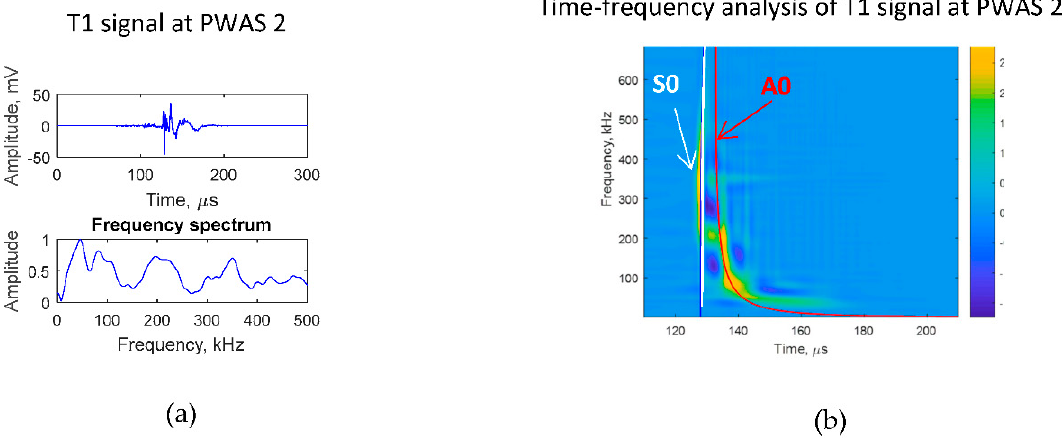
Figure 15. Time-frequency analysis of T1 AE signal at PWAS–2: ( a ) T1 signal at PWAS–2; ( b ) Choi– Williams transform of the T1 signal at PWAS–2. A strong S0 Lamb wave mode was observed for the T1 signal at PWAS − 2.